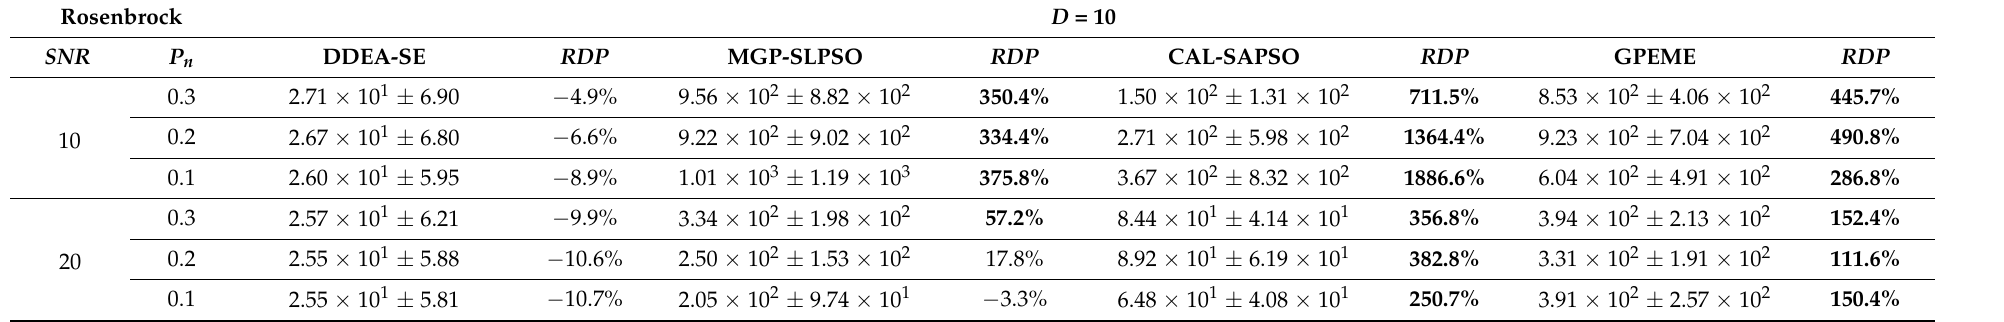
Table A3. Experimental results (with standard deviation) and RDP of DDEAs on 10-dimensional Rosenbrock